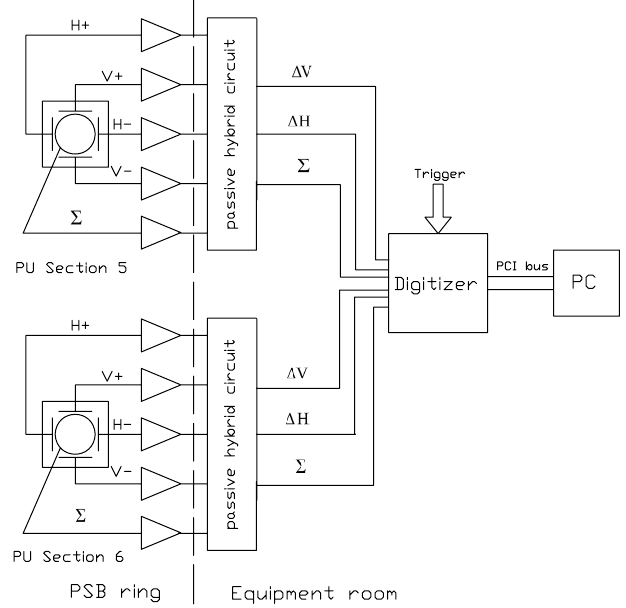
FIG. 18. Schematic view of the multiturn beam position acquisition system.